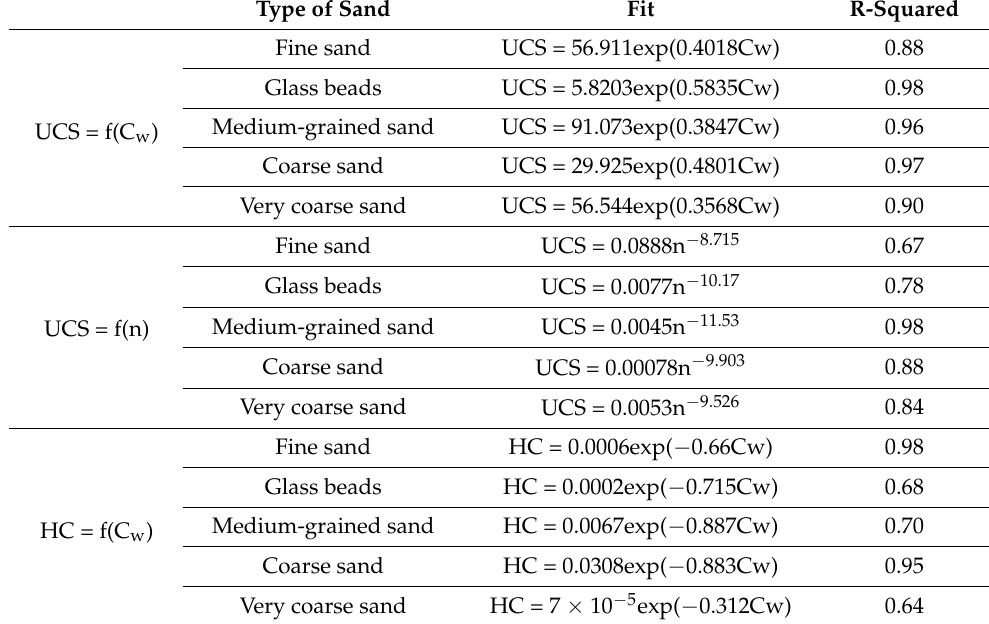
Table 3. The fits of the mechanical and physical properties of the bio-treated